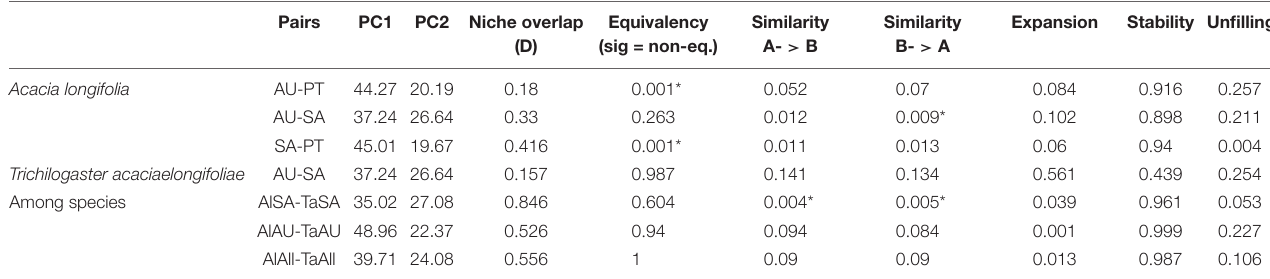
TABLE 2 | Niche overlap and dynamics between all pairs of native (AU: Australia) and introduced (SA: South Africa; PT: Portugal) Acacia longifolia (Al) and Trichilogaster acaciaelongifoliae (Ta). Pairs PC1 PC2 Niche overlap Equivalency (D) (sig = non-eq.)